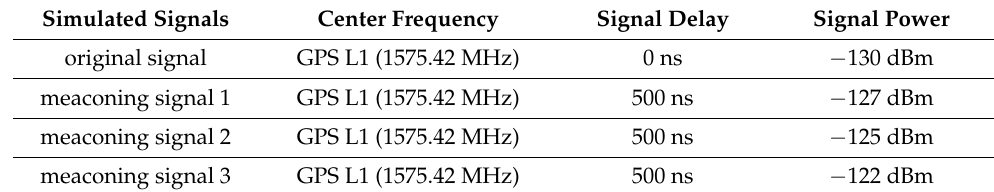
Table 1. Key parameters of simulated signals.